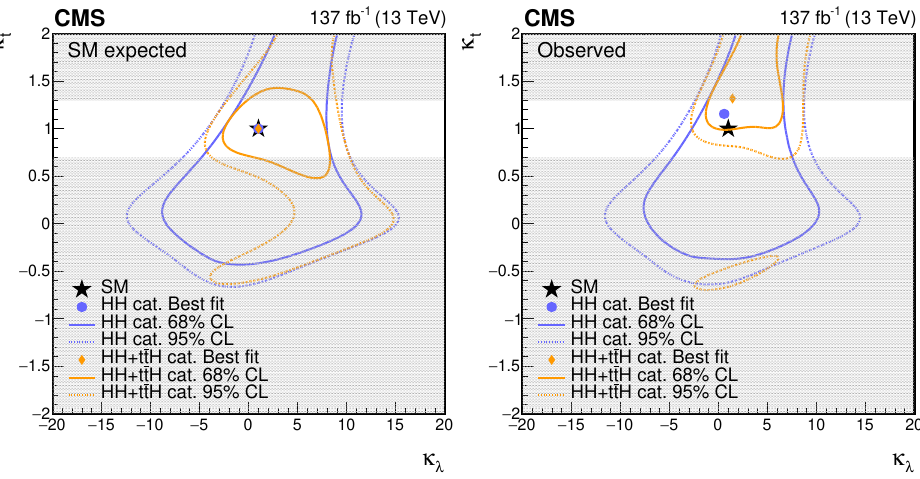
, κ ) plane evaluated with Figure 12 . Negative log-likelihood contours at 68 and 95% CL in the ( κ λ t an Asimov data set assuming the SM hypothesis (left) and the observed data (right). The contours obtained using the HH analysis categories only are shown in blue, and in orange when combined with the ttH categories. The best fit value for the HH categories only ( κ = 0 . 6 , κ = 1 . 2 ) is λ t indicated by a blue circle, for the HH + ttH categories ( κ = 1.4, κ = 1.3) by an orange diamond, λ t and the SM prediction ( κ = 1.0, κ = 1.0) by a black star. The regions of the 2D scan where the λ t parametrization for anomalous values of κ at LO is not reliable are shown with a gray band. κ t λ